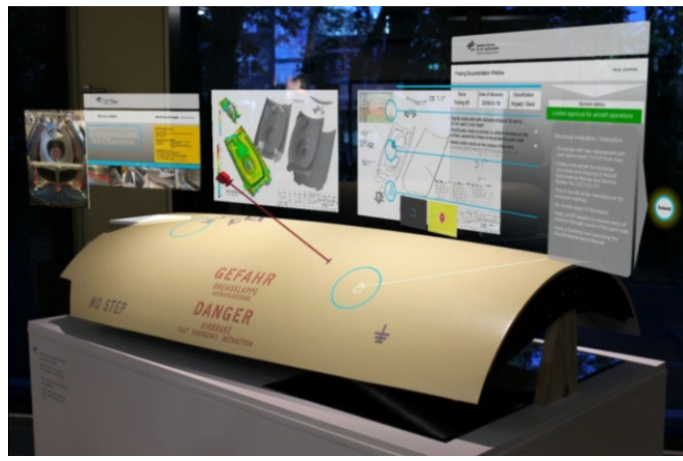
Figure 11. Collaborative inspection of an aircraft part. The expert’s avatar is represented by the red box and his gaze by the red beam [72].